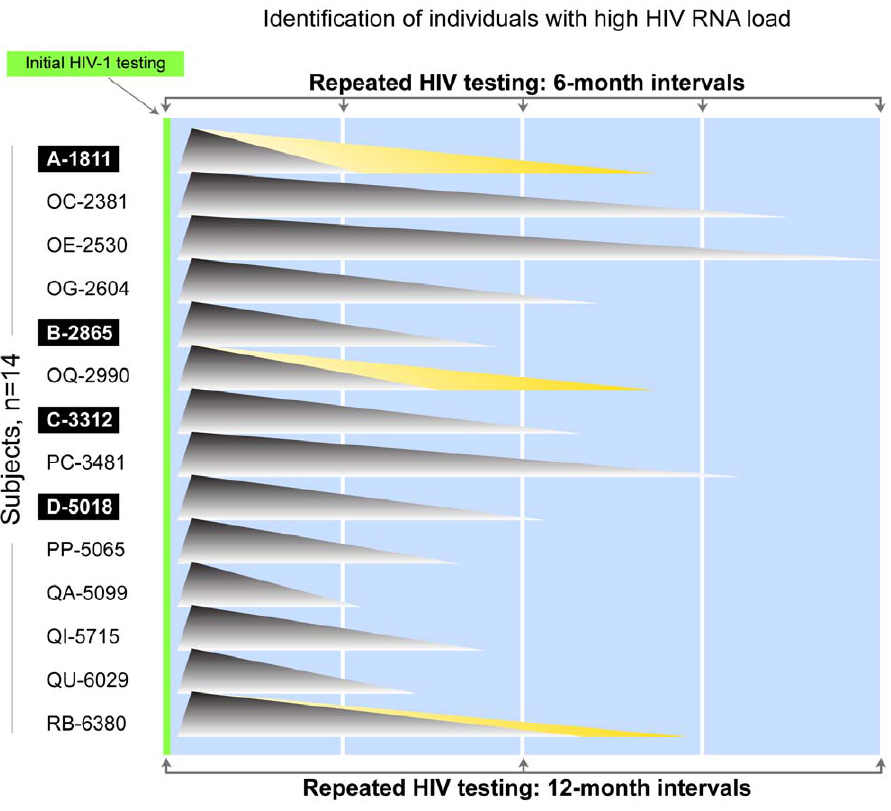
Figure 5. Identification of high HIV-1 RNA individuals by repeated HIV testing: six-month intervals vs. twelve-month intervals. All subjects are assumed to be HIV-seronegative at initial HIV testing, and to acquire HIV-1 infection shortly after that. The study subjects’ code is shown at the left of the graph, and four acutely infected individuals are highlighted. The high viral load for each subject is presented as a shaded triangle symbolizing the ‘‘tip of the viral load iceberg’’. The base of each triangle corresponds to the estimated time of dropping HIV-1 RNA levels below 50,000 (4.7 log 10 ) copies/ml for each subject. In all subjects estimation of high viral load duration is outlined by gray shading delineating the time from seroconversion to the last observation before cART. In addition, in three subjects —A-1811, OQ-2990, and RB-6380—yellow shading corresponds to estimation of high viral load duration using the Kaplan-Meier method. Six-month interval HIV testing is delineated at the top, and 12- month interval testing is shown at the bottom.